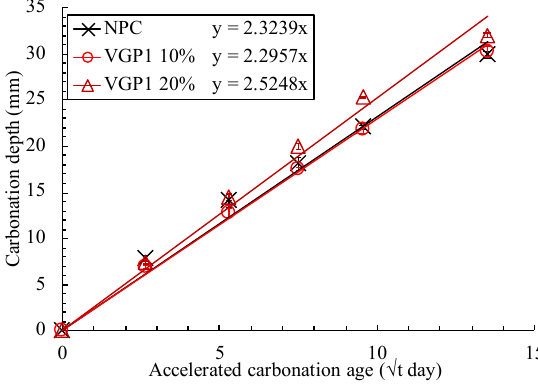
Figure 20. Carbonation depth and accelerated